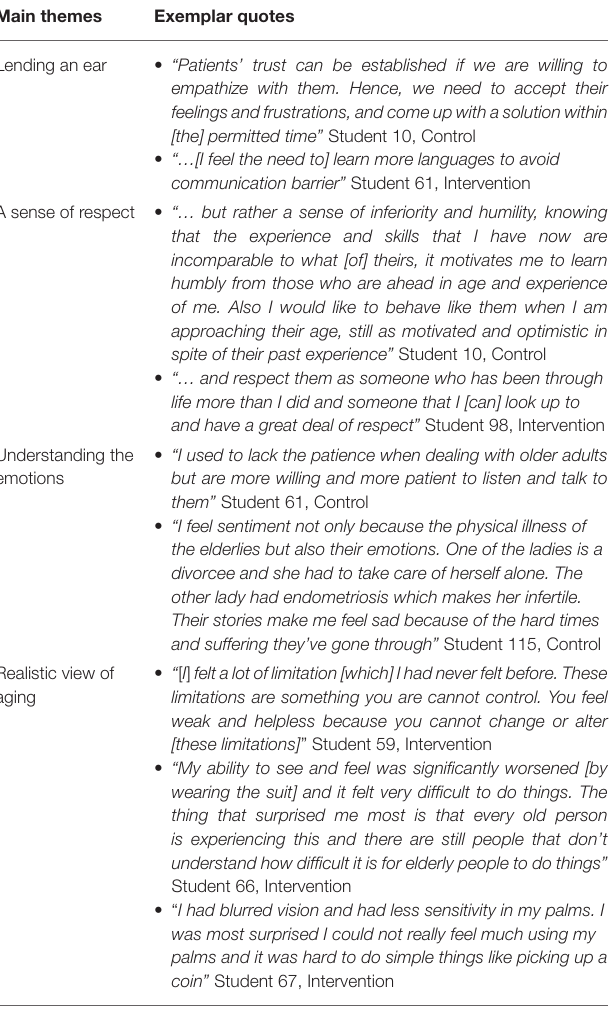
TABLE 3 | Key themes identified in the current